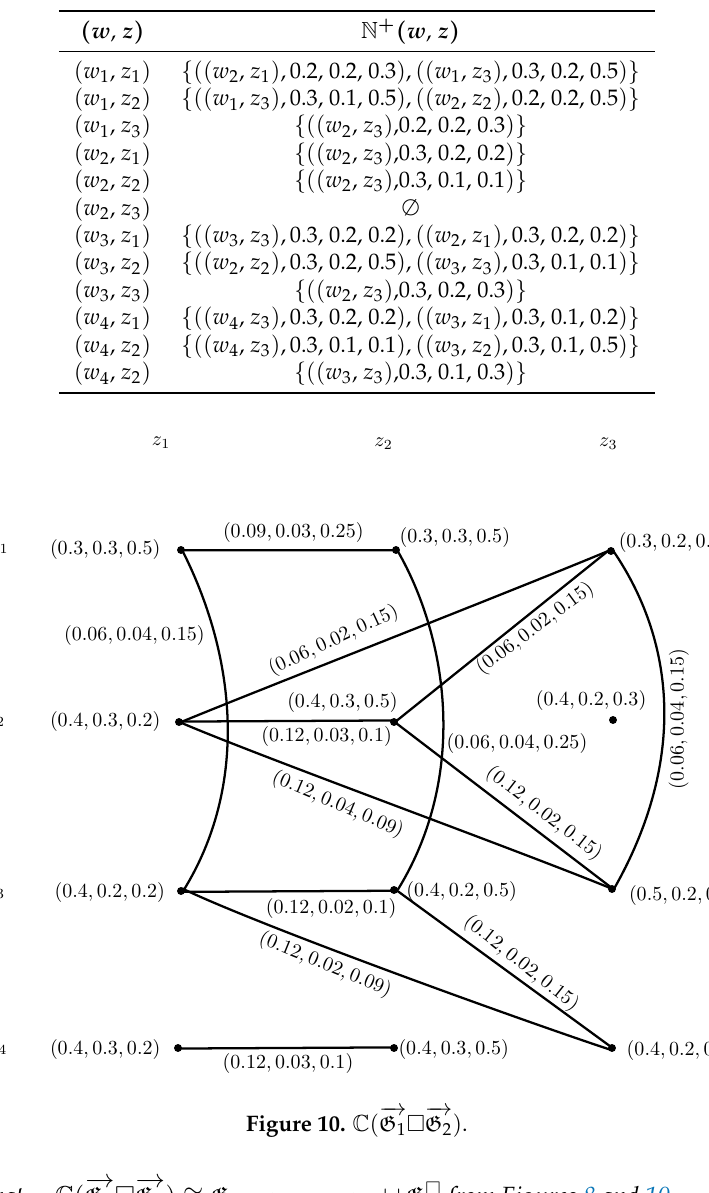
Table 6. IN-out-neighborhoods of −→ G 1 (cid:3) −→ G 2 .